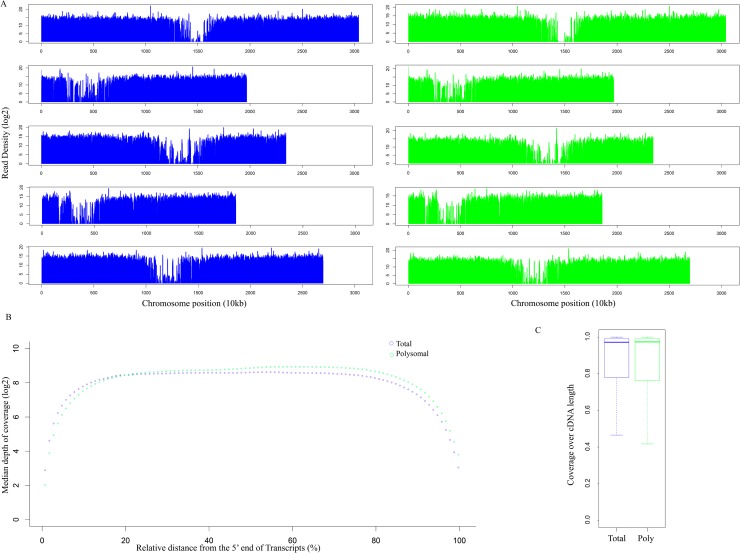
Coverage profiles along A. thaliana chromosomes and TAIR10 annotated CDS.(A) Distribution of RNA-seq read density along chromosome length is shown for total RNA-seq (left) and polyribosomal RNA-seq (right). The y axis represents the log2 scale of median read density. (B) Distribution of the RNA-seq read coverage along the length of the transcriptional unit. The log2 scale of median depth of coverage along the length of each individual TAIR10 annotated cDNA was calculated and plotted against the relative length of the transcriptional unit for the total RNA-seq and polyribosomal RNA-seq. (C) Coverage over the length of TAIR10 annotated CDS. Box-and-whisker plots depict the coverage calculated as the percentage of bases along the length of the cDNA sequence that was supported by reads from the total and polyribosomal RNA-seq datasets. The bottom and top of the boxes represent the 25th and 75th quartiles, respectively. The lines within boxes represent the medians.